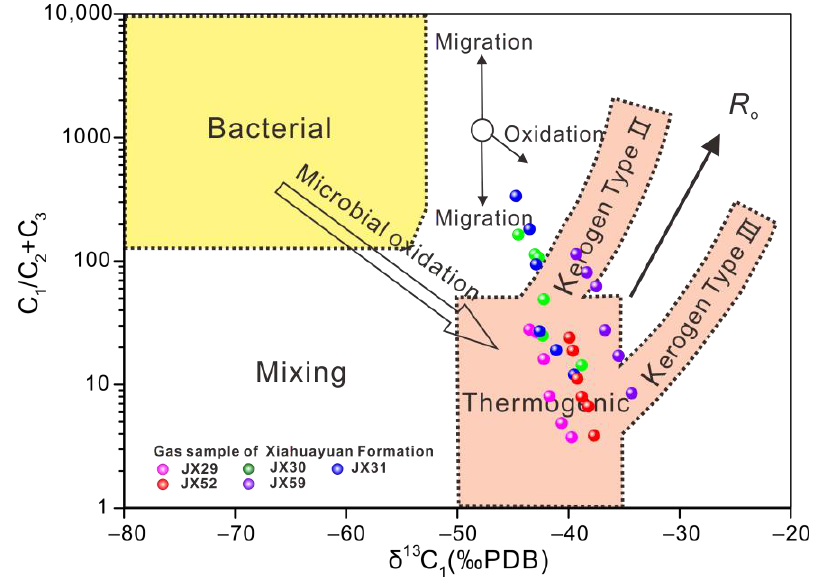
Figure 7. Natural gas interpretative “Bernard” diagram (δ 13 C CH4 versus CH 4 /(C 2 H 6 +C 3 H 8 )). Modified after [71,72].